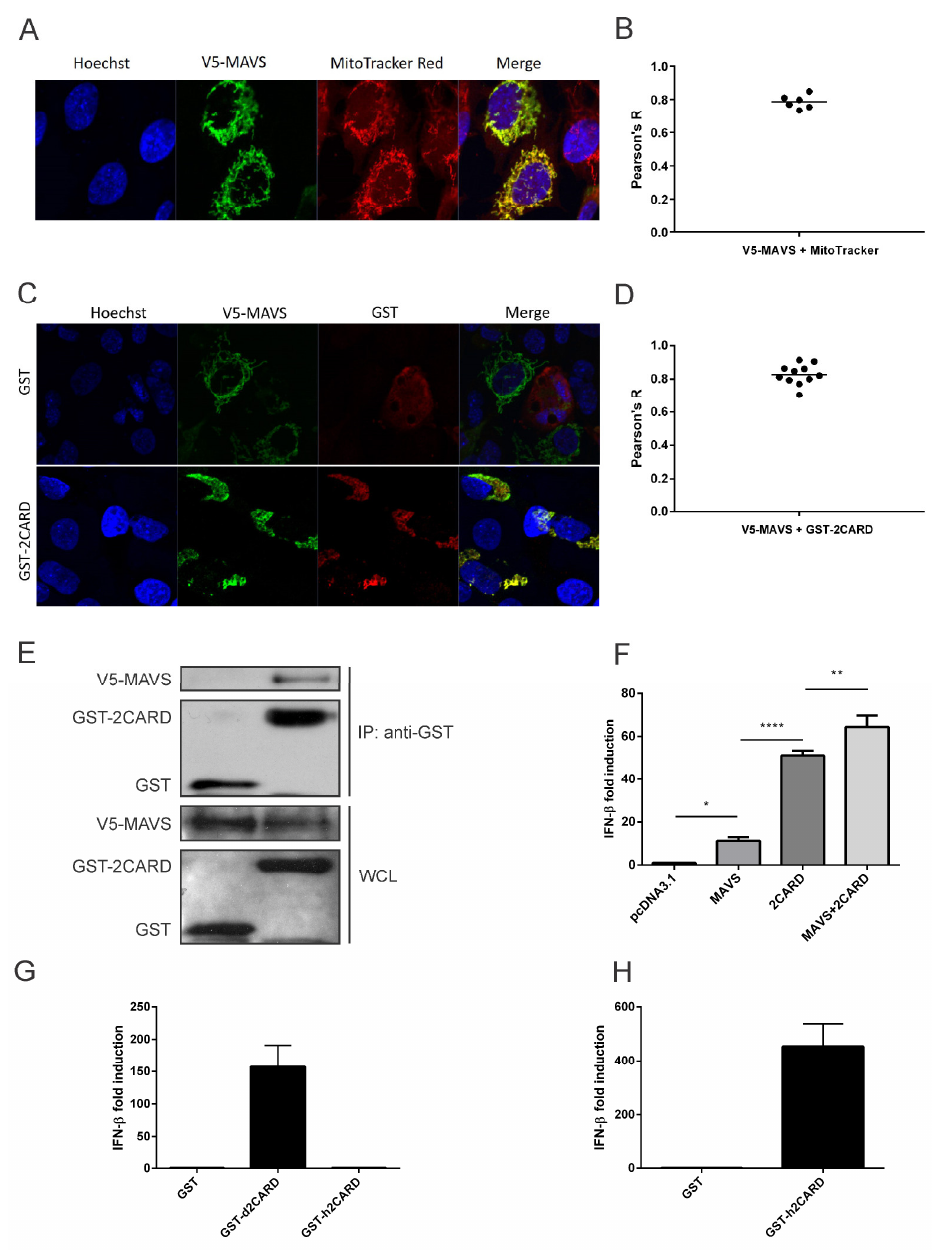
Figure 2. Duck MAVS localizes to mitochondria and interacts with duck RIG-I CARD domains in DF-1 cells. ( A ) DF-1 cells overexpressing duck MAVS (V5-MAVS, green) were also stained to show mitochondria (MitoTracker Red) and nuclei (blue). Original magnification X1000. ( B ) Co-localization of V5-MAVS with mitochondria was quantified using Pearson’s correlation coe ffi cient (Pearson’s R). Bar shows mean value from 6 analyzed cells. ( C ) DF-1 cells overexpressing duck MAVS and GST-tagged duck RIG-I CARD domains (GST-2CARD) or GST alone were stained for GST (red) and V5-MAVS (green). ( D ) Co-localization of V5-MAVS with GST-2CARD was quantified using Pearson’s correlation coe ffi cient (Pearson’s R). Bar shows mean value from 11 analyzed cells. ( E ) DF-1 cells overexpressing V5-MAVS and GST-2CARD were lysed. Clarified whole cell lysates (WCL) were subjected to GST pulldown (anti-GST) and blotted with anti-GST and anti-V5 antibodies. ( F ) Duck MAVS and RIG-I-CARD overexpression promotes chicken IFN- β promoter activity in DF-1 cells as measured by dual luciferase assay. Graph bars show mean ± standard deviation (SD) of three independent experiments ( n = 3). Means were compared using one-way analysis of variance (ANOVA) with a Tukey’s multiple comparisons post-hoc test (*, p ≤ 0.05; **, p ≤ 0.01; ***, p ≤ 0.001). ( G ) In